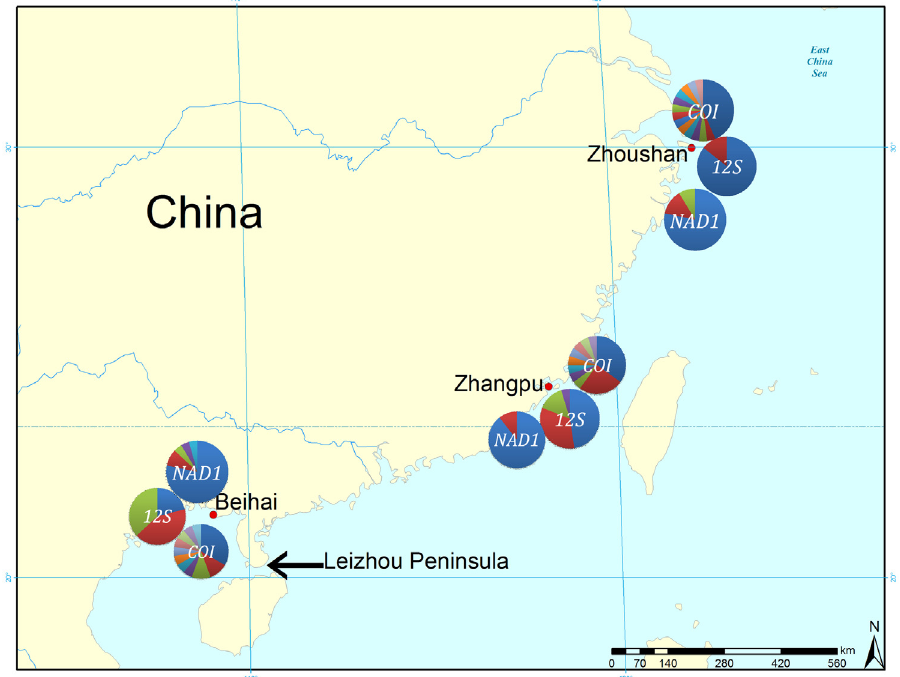
Fig 1. A map illustrating the three sample sites of M . multifarius populations in the East China Sea (Zhoushan [ZS] and Zhangpu [ZP]) and Beibu Gulf (Beihai [BH]). Different haplotypes for each gene have been separated by color, with the two most common haplotypes (H1 and H2) shown in blue and red,